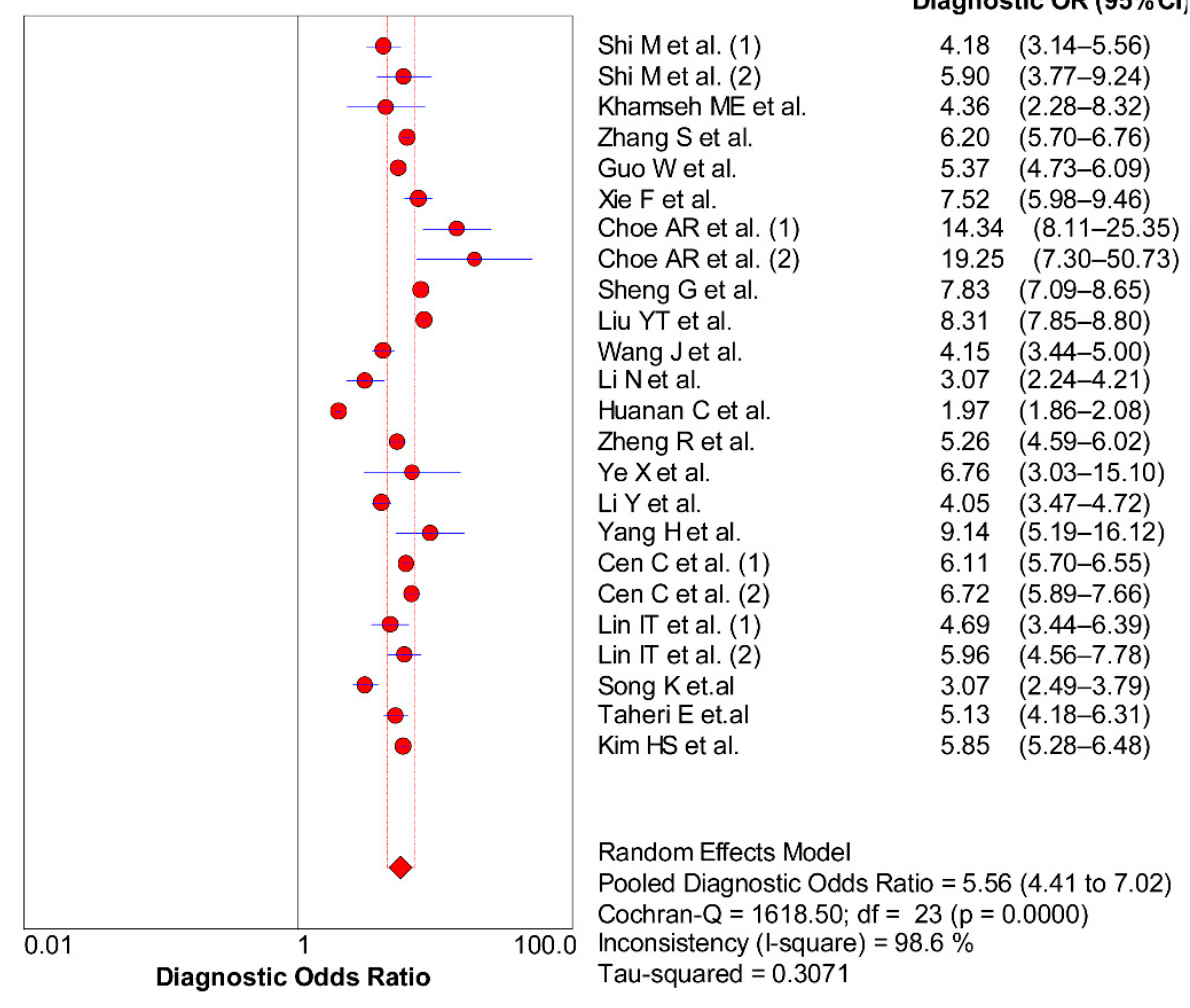
Figure 6. Forest plot of DOR with corresponding 95% CI of TyG for MAFLD [10,21–39].